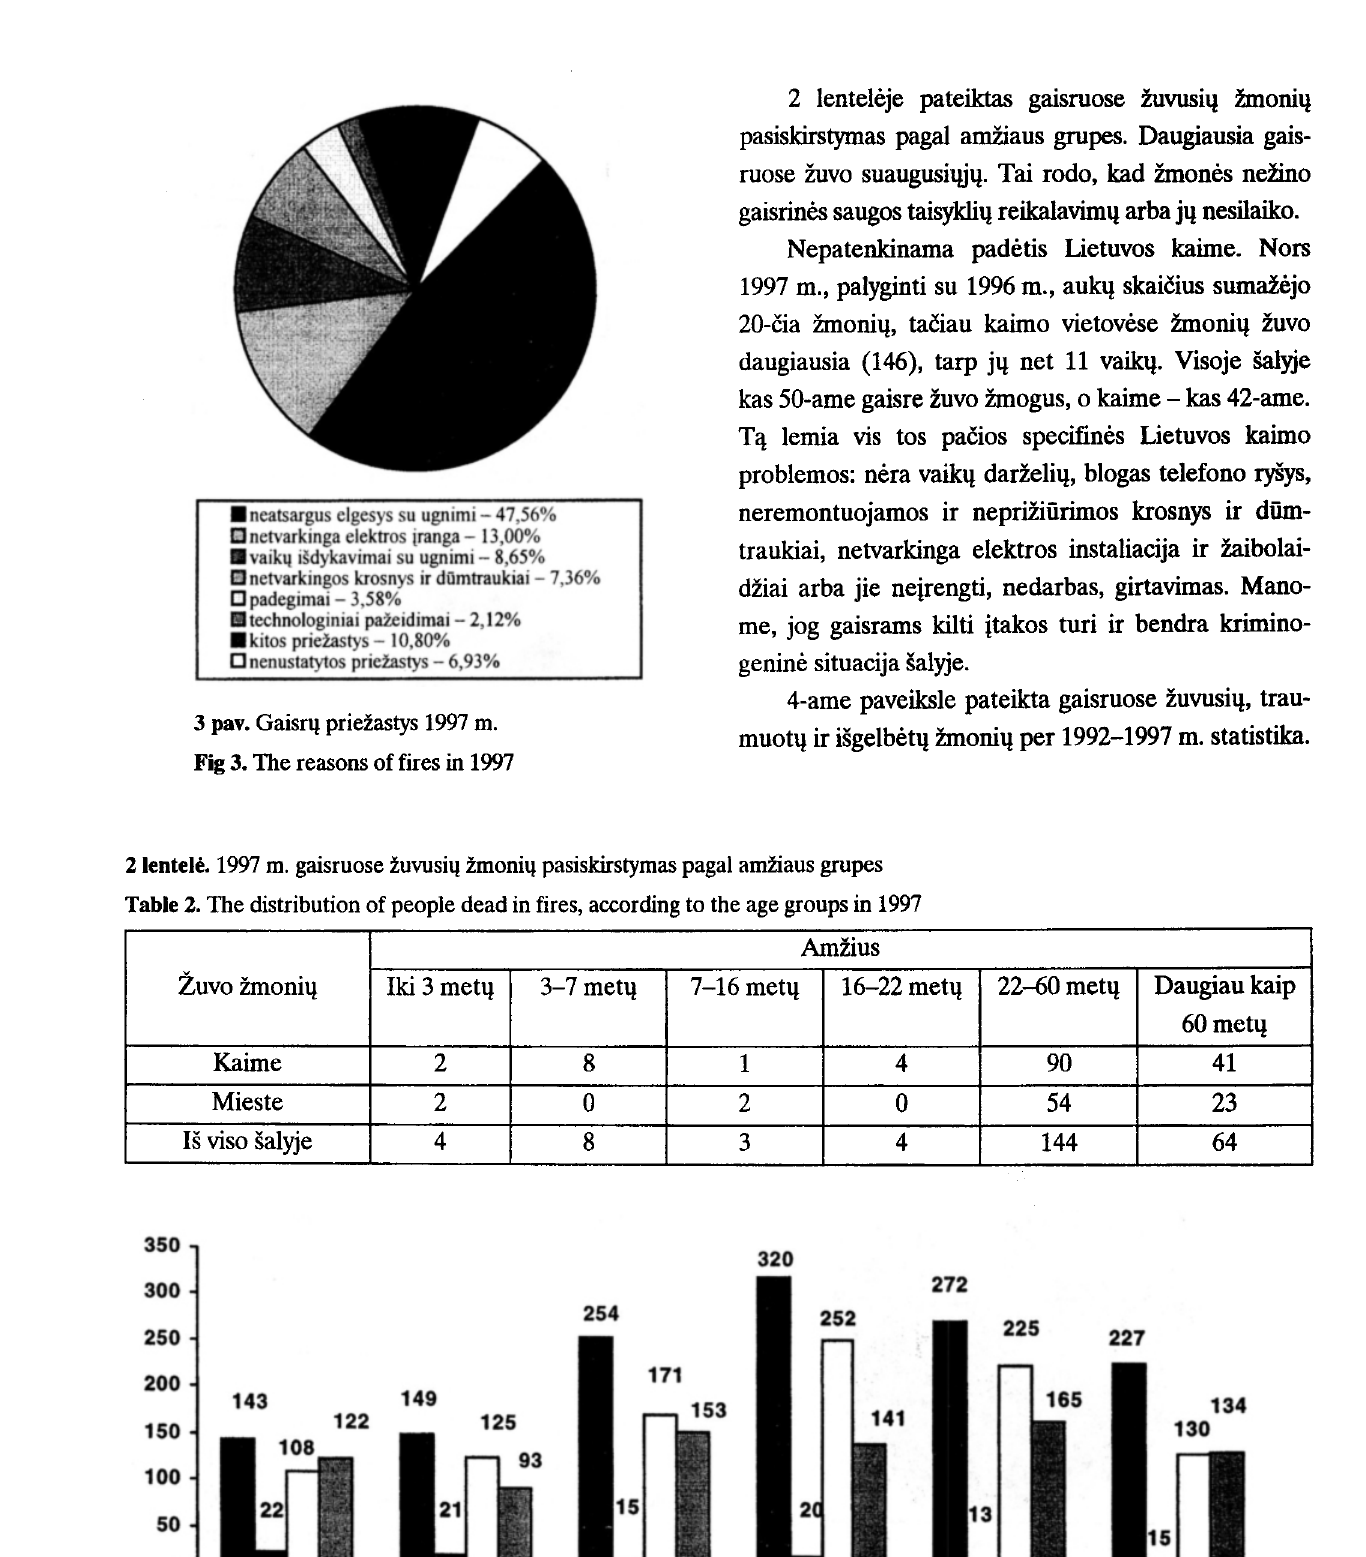
Fig 4. The number of people who died or were traumatised in 1992-97